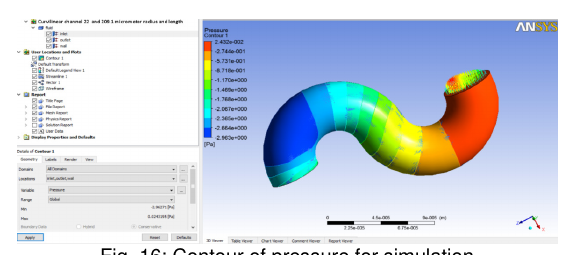
Fig. 15 (a): Design Modeler